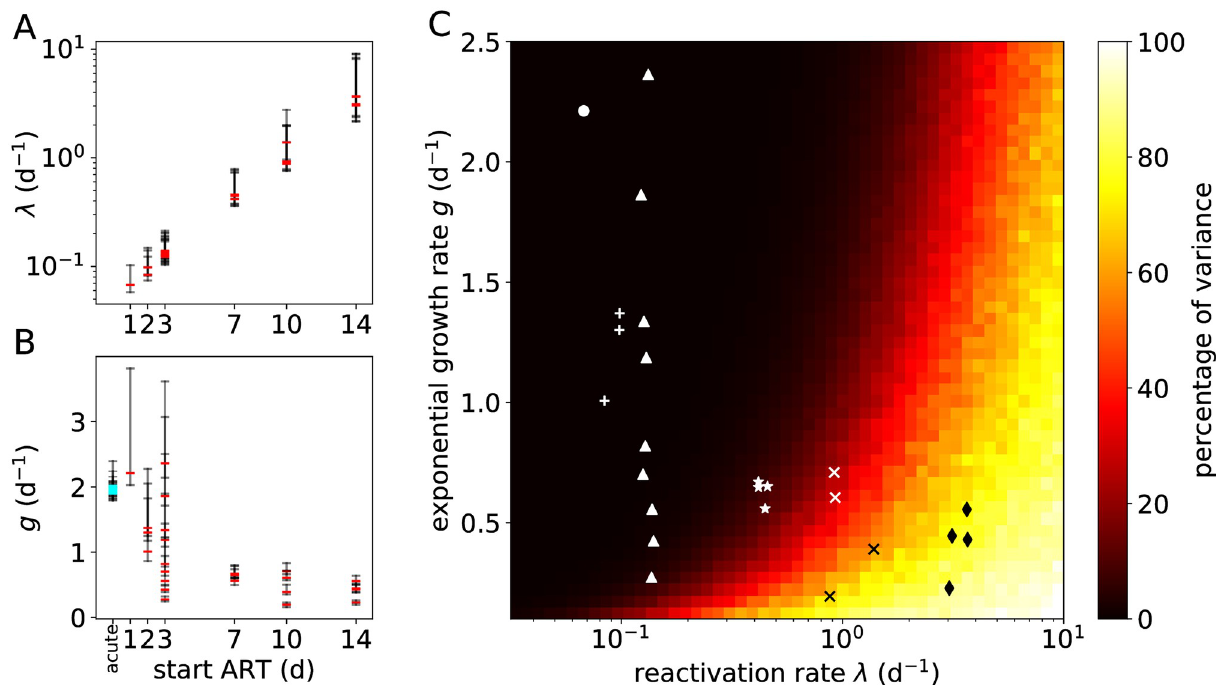
Fig 4. Estimates of recrudescence and growth rates from the SIV rebound data and the percentage of the variance of the time-to-rebound. (A) Point estimates (posterior modes; red) and 50% CrIs (black) of λ for each macaque as a function of the time ART was initiated. (B) Estimates of g . The cyan markers denote estimates of the growth rate for acute infections of 13 of the 25 macaques. These acute VL growth rates cluster around 2 d − 1 . (C) Proportion of the total variance due to secondary reactivation events. The heat map shows Var[ τ 1 ]/Var[ τ 0 ] � 100%, where τ the rebound time ( i = 0) or the time between the first successful reactivation and rebound ( i = 1). Additional parameters are v 0 = 0.1 copies mL − 1 and ℓ = 50 copies mL − 1 . The markers indicate the estimates from macaque SIV rebound experiments in which the macaques were treated, starting t ART days after infection, with t ART equal to 1 day ( ● ), 2 days (+), 3 days ( ▲ ), 7 days ( $ ), 10 days ( × ), or 14 days ( ♦ ).